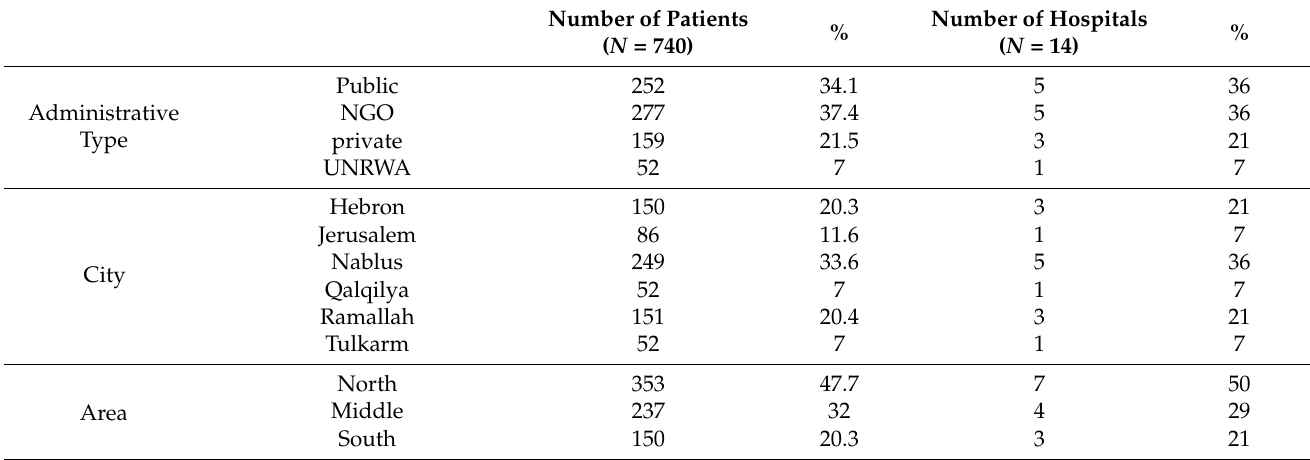
Table 3. Number of patients and hospitals based on hospital